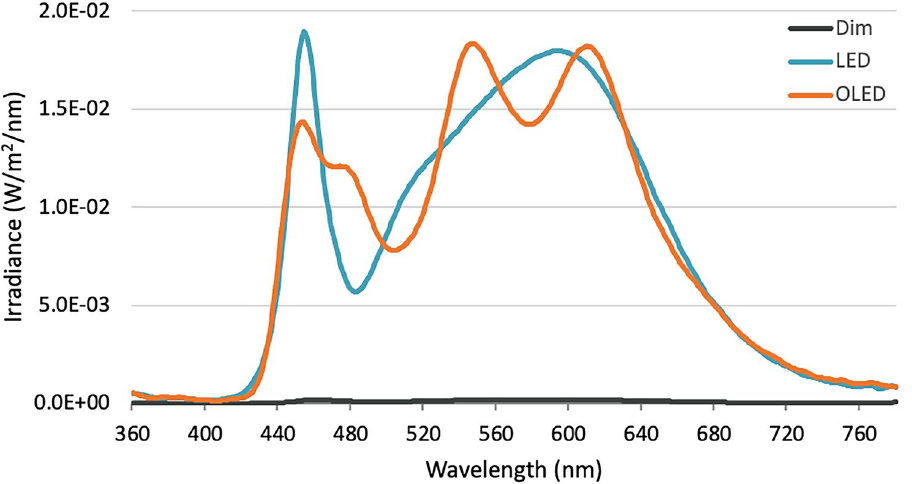
Figure 6. Spectral power distribution of LED, OLED, and dim lights expressed in